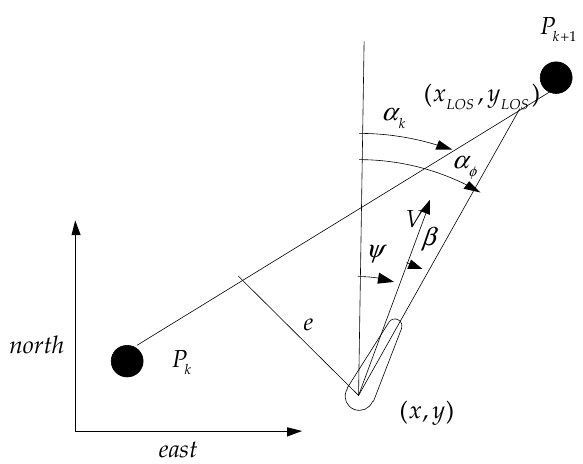
Figure 4. Principle diagram of the LOS trajectory tracking algorithm.